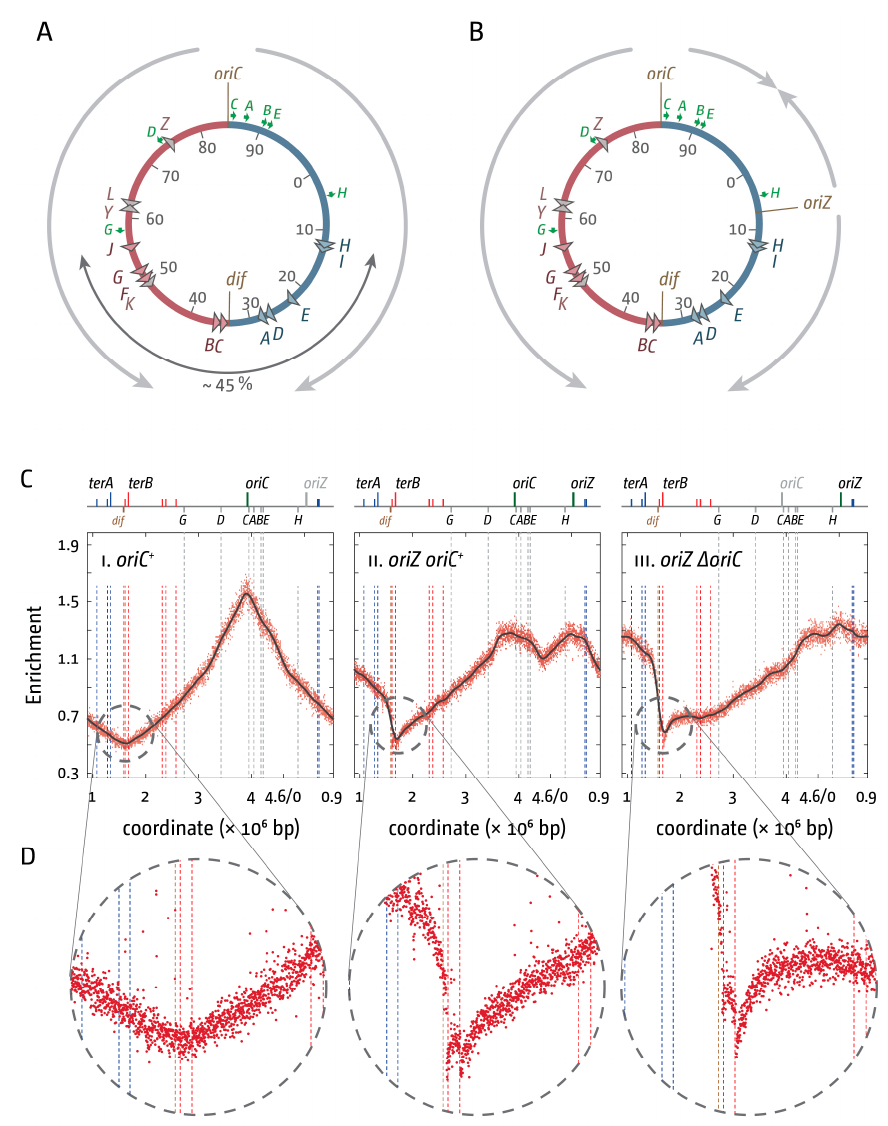
Figure 1. Replication fork fusion sites in E. coli cells with one and two replication origins. ( A ) Schematic representation of the replichore arrangement of the E. coli chromosomes. Direction of replication from the origins is indicated by grey arrows. The origin, oriC , and the dif chromosome dimer resolution sites are indicated. All ter sites are highlighted by triangles and identified by their corresponding letter (“A” indicates the terA site). The colour of the triangles corresponds with the replichore for which replication is permissive ( ter sites highlighted in blue will block forks coming from the red replichore and vice versa). The secondary ter sites terK , L Y , and Z are shown in grey. Numbers represent the minutes of the standard genetic map (0–100 min). Green arrows represent location and direction of transcription of the 7 rrn operons A–E , G , and H ; ( B ) Schematic representation of the replichore arrangement of the E. coli chromosome in cells with two replication origins. oriZ indicates the integration of a duplication of the oriC sequence near the lacZYA operon; ( C ) Marker frequency analysis of E. coli oriC + , oriC + oriZ , and ∆ oriC oriZ cells. The number of reads (normalised against reads for a stationary phase wild type control) is plotted against the chromosomal location. Note that the chromosomal location starts at 0.9 Mbp for a better visualisation of both replication origins. A schematic representation of the E. coli chromosome showing positions of oriC and oriZ (green line; grey if deleted/not present) and ter sites (above) as well as dif and rrn operons A–E, G, and H (below) is shown above the plotted data. The grey line shows a LOESS regression curve of the marker frequency data. Data are re-plotted from [10]; ( D ) Detail view of the native termination area of the E. coli chromosome. See text for details.